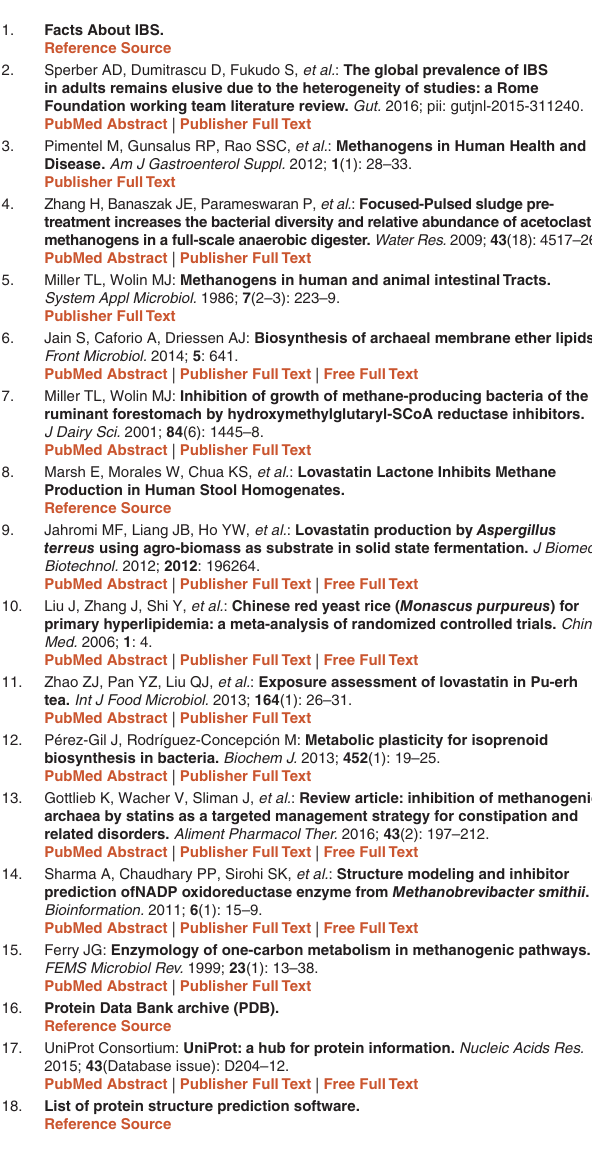
Figshare : Lovastatin-lactone v. F420 in the A5UMI1 site. doi: 10.6084/m9.figshare.3126538